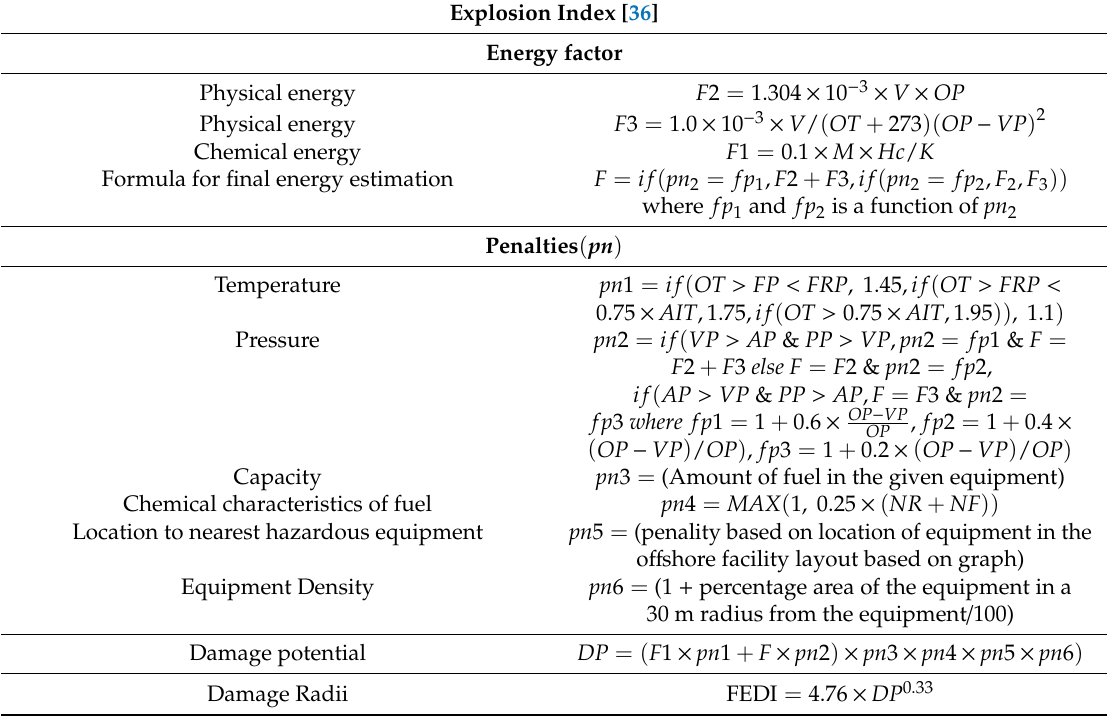
Table 1. Hazard Identification and Ranking Analysis (HIRA) formulation. Reproduced with permission from Niazi et al. [33], Process Safety Progress; published by Wiley,